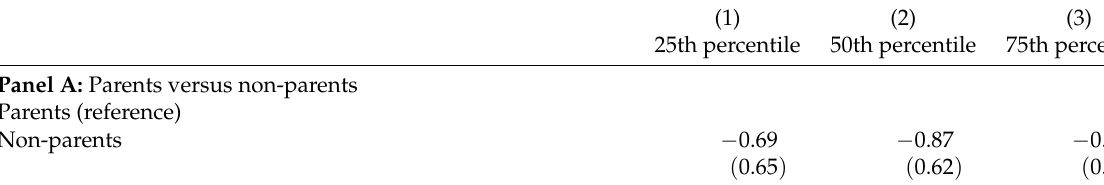
Table 3: Quantile regressions of percentile net worth, by household type ( N = 41,